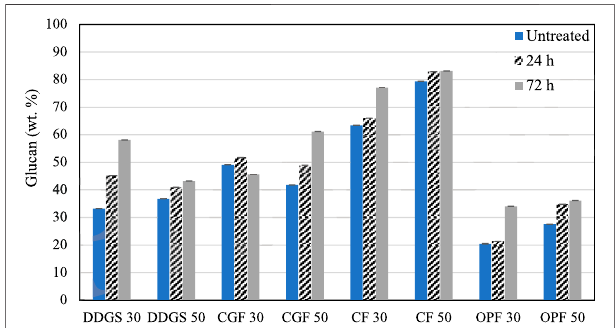
FIGURE 2 | Glucan content in the biomass after LMAA pretreatment. Error bars represent ± standard deviations. DDGS, distillers dried grains with solubles; CGF, corn gluten feed; CF, corn fi ber; OPF, oil palm frond. Numbers in the x-axis indicate moisture content designation.